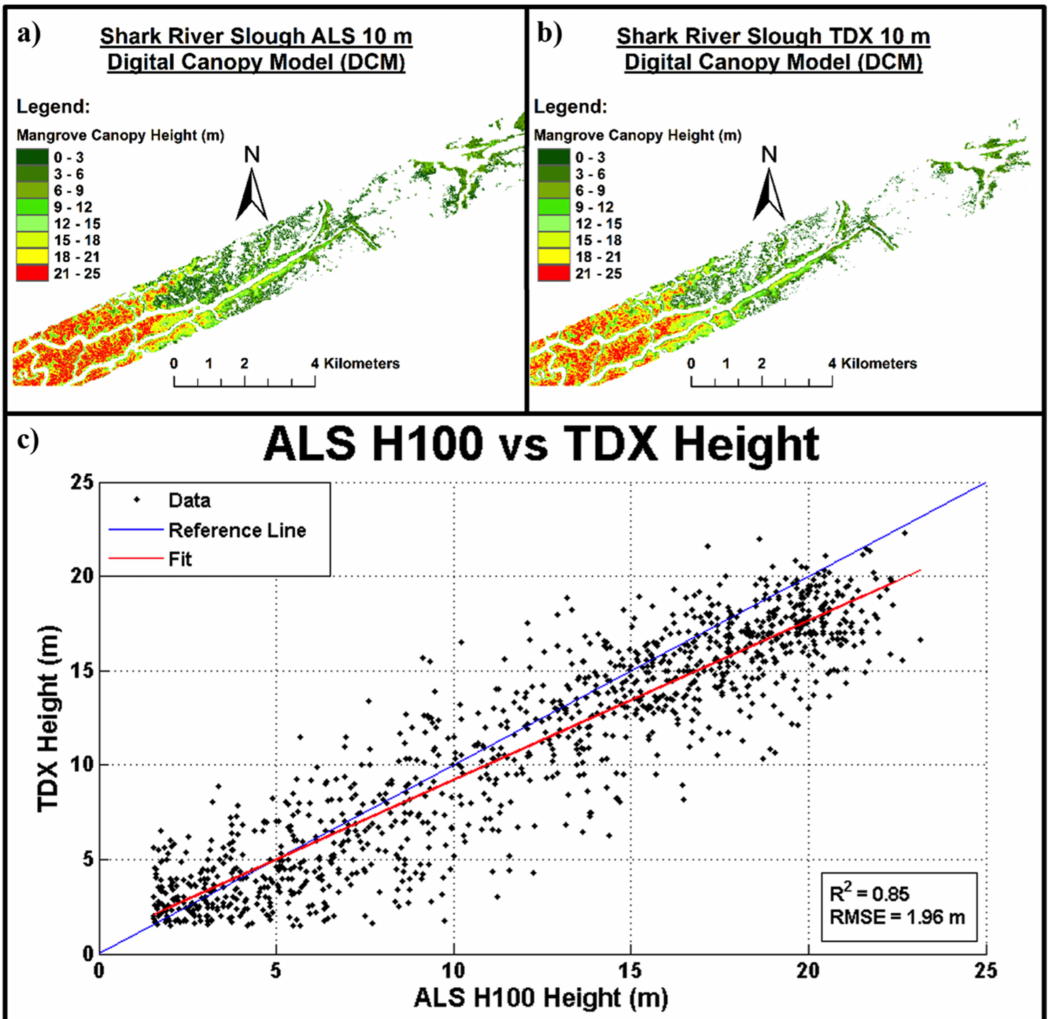
Figure 7. A comparison between ALS H100 and TDX canopy height results along the SRS swath. ( a ) ALS H100-derived 12-m SRS DCM; ( b ) TDX-derived 12-m SRS DCM; ( c ) Linear regression